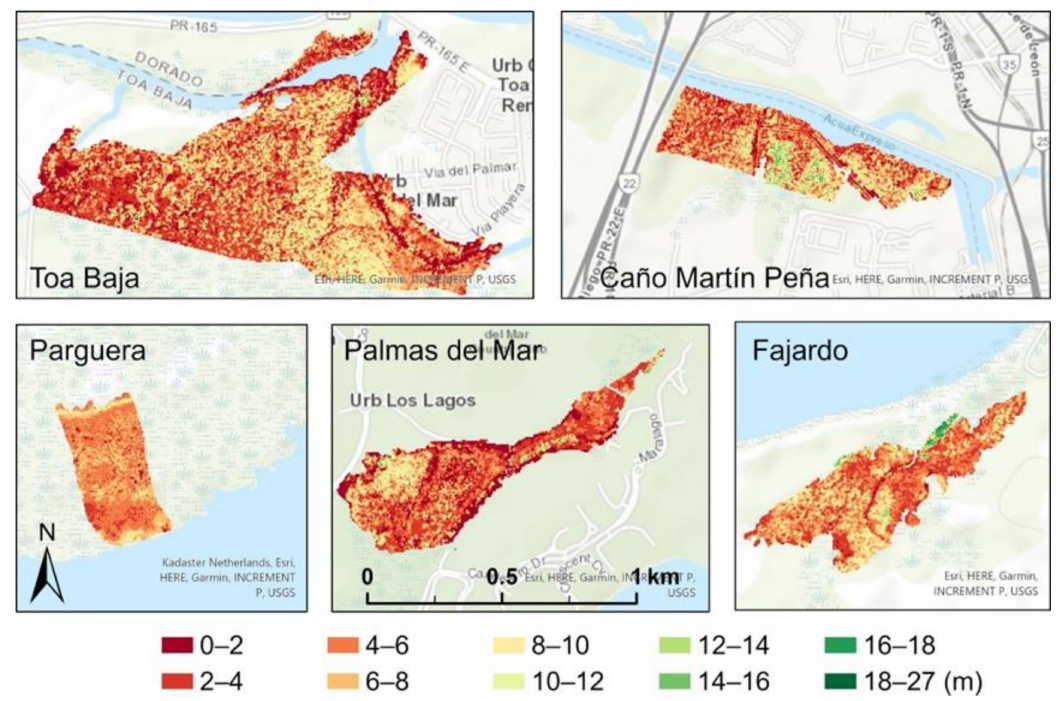
Figure 4. The post-hurricane canopy height, derived from the USGS LiDAR point clouds.